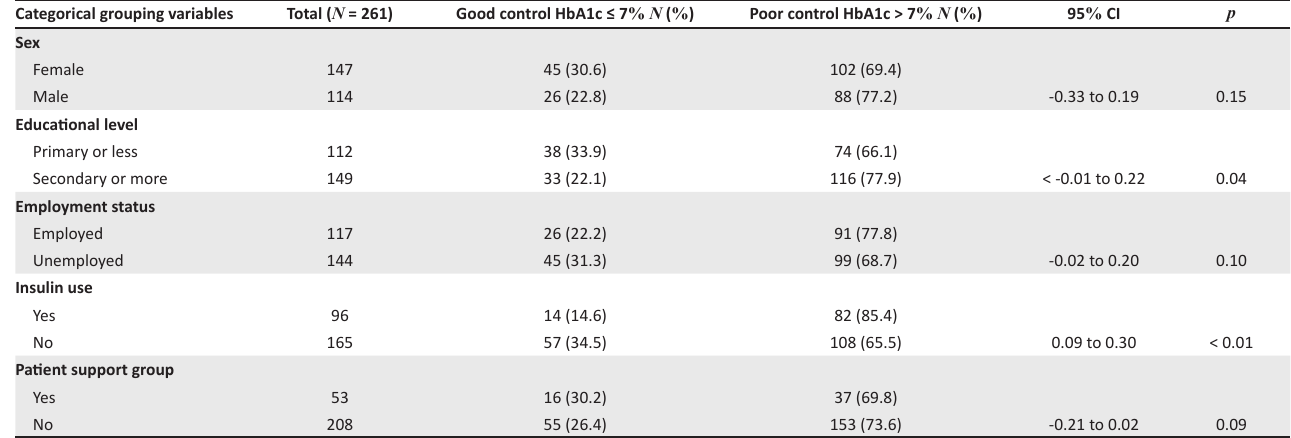
TABLE 4: Baseline characteristics of study population analysed against glycaemic control. Categorical grouping